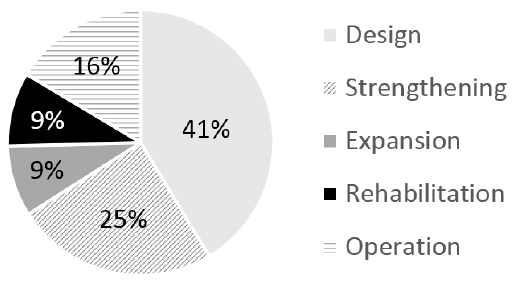
Figure 2. Application areas (of papers from the appendix table).